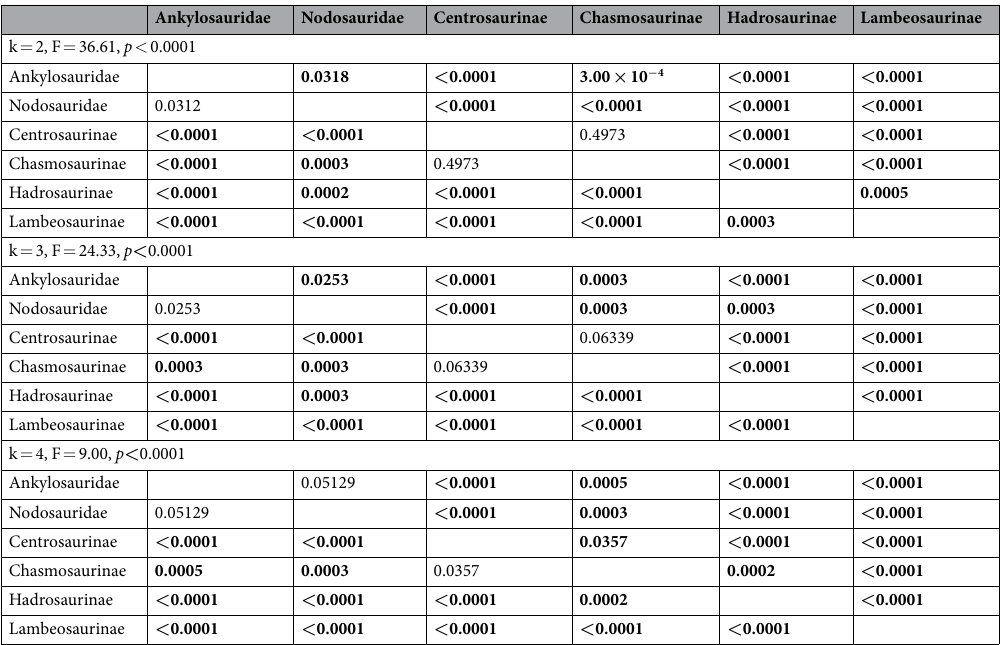
Ankylosauridae Nodosauridae Centrosaurinae Chasmosaurinae Hadrosaurinae Lambeosaurinae k = 2, F = 36.61, p < 0.0001